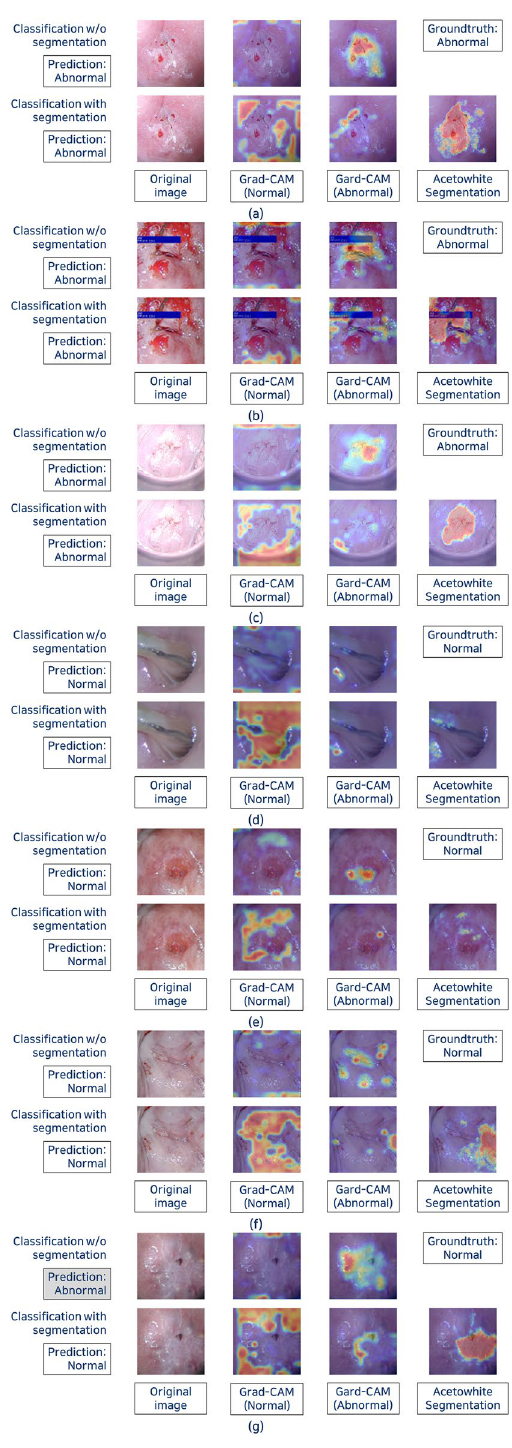
Figure 8. Examples of gradient-weighted class activation map (Grad-CAM) of classification. ( a ) to ( c ): Abnormal cases / ( d ) to ( g ): Normal